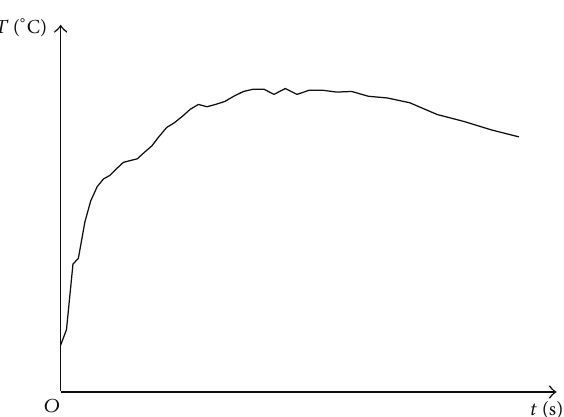
Figure 11: Typical curve of the instant surface temperature during emergency braking.